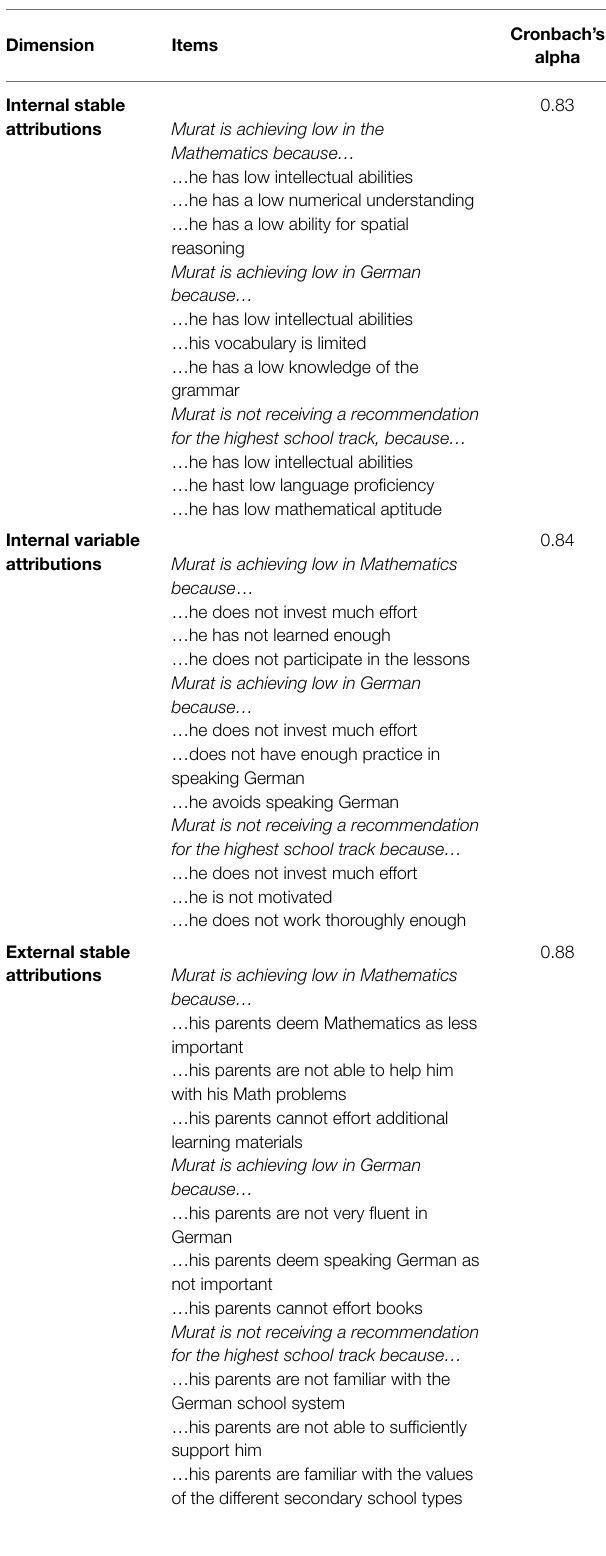
TABLE 1 | Items of the causal attributions questionnaire and Cronbach’s alphas for the four Weiner’s dimensions.